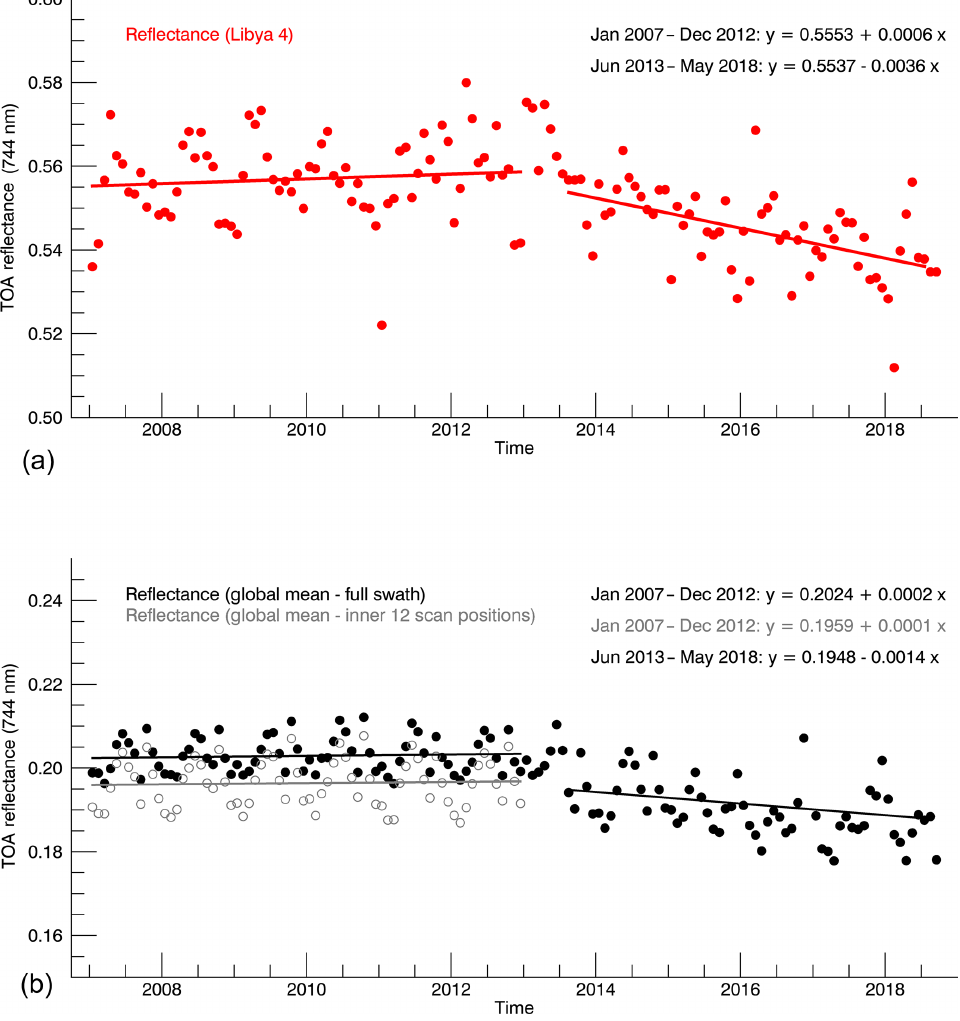
Figure 1. Top-of-atmosphere reflectance measured by GOME-2A at 744nm as a function of time for Libya4 ( a , red) and globally for each of the 24 scan mirror positions in the forward scan ( b , black) and for the 12 inner scan mirror positions ( b , grey). GOME-2A had 80 × 40km 2 pixels until 15 July 2013, and a narrower swath with 40 × 40km 2 pixels after that date. The solid lines indicate the linear trend in reflectance obtained in the early GOME-2A period for a period of exactly 6 years (January 2007–December 2012) and in the late GOME-2A period for exactly 5 years, when pixels were smaller (August 2013–July 2018). The x in the regression equation is the fractional number of years relative to January 2007 or June